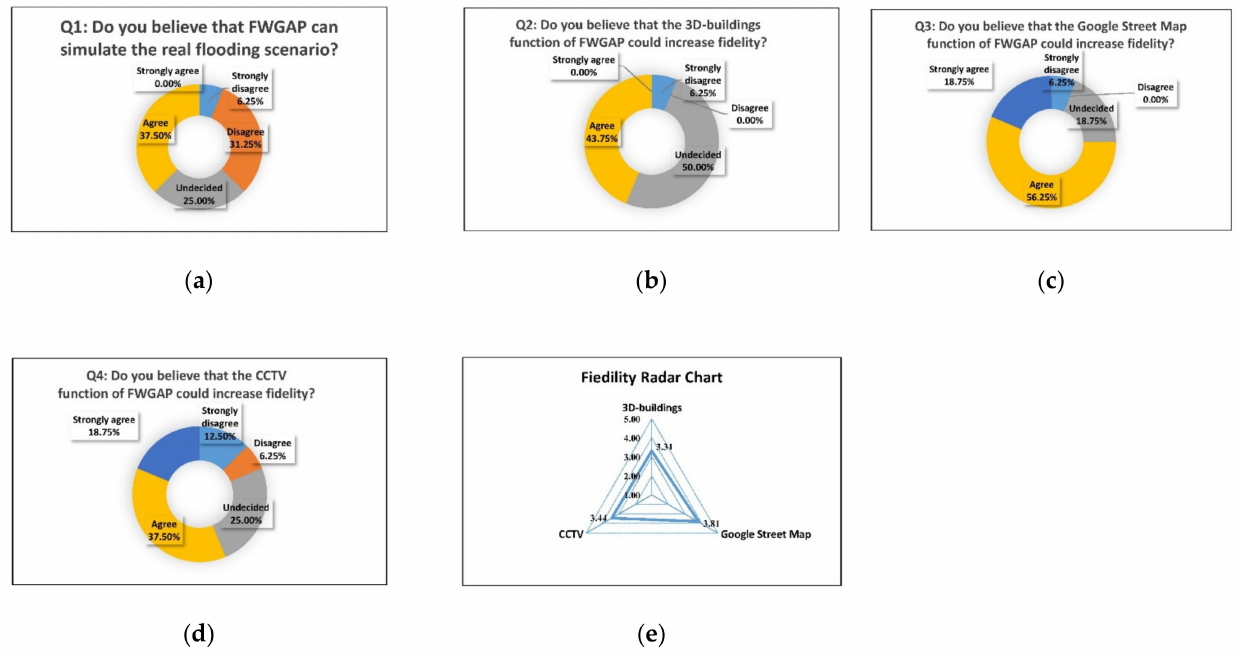
Figure 21. Assessment of the simulation’s fidelity: ( a ) real flood scenario simulation, ( b ) 3D-buildings, ( c ) Google Map, ( d ) CCTV, and ( e ) radar